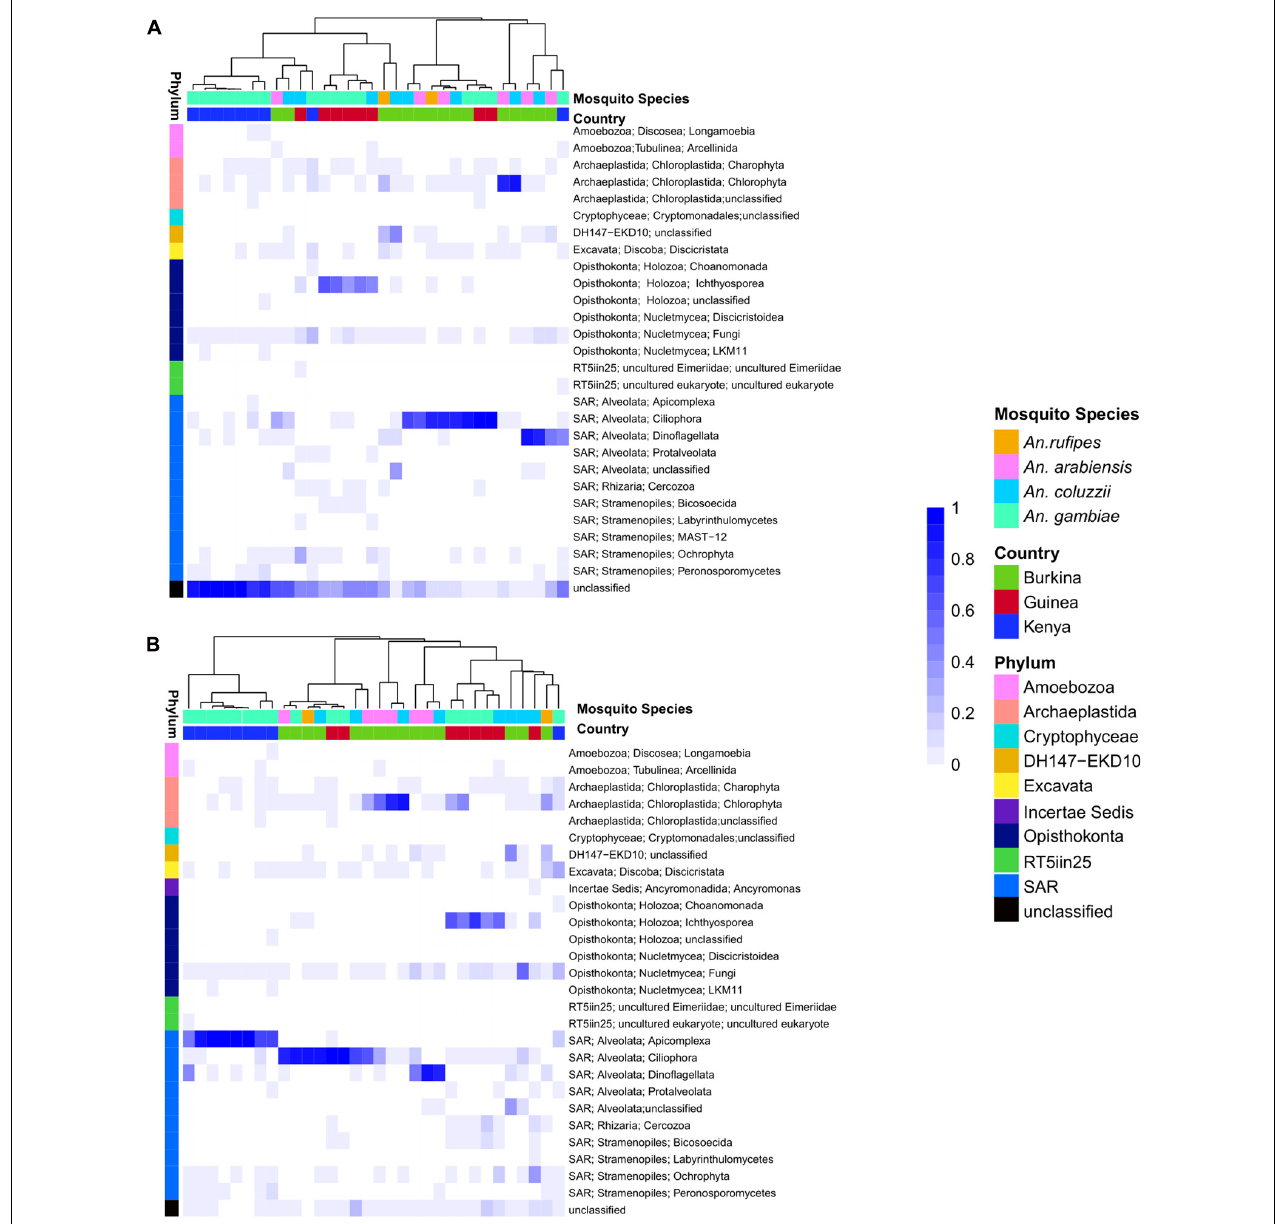
FIGURE 1 | (A) Heatmap depicting the similarity in composition of micro eukaryotic members of the microbiome from field collected larvae displays clustering due to geography. The heatmap is clustered by microbiome similarity and both mosquito species and country of origin are shown above the heatmap for each sample with keys to the right of the heatmap. The dendrogram above the heatmap depicts overall micro eukaryotic microbiome similarity. The colored vertical bar on the left of the heatmap depicts the OTU Phylum membership with a key to the right of the heatmap. Each column represents a single pool of mosquito larvae subjected to 18S rRNA gene V9 amplicon sequencing and each row of the heat map show the relative proportion of one eukaryotic Order. The shade of blue indicates the proportion of the microbiome occupied by a particular Order; key to right of heatmap. (B) As in A except after application of the Evolutionary Placement Algorithm (EPA) which was used to assign many of the previously unassigned sequence reads to known phyla based on evolutionary relatedness as described in greater details in the methods. This phylogenetically informed process assigned on average 34.8% of previously unclassified sequences per field sample to known Orders.